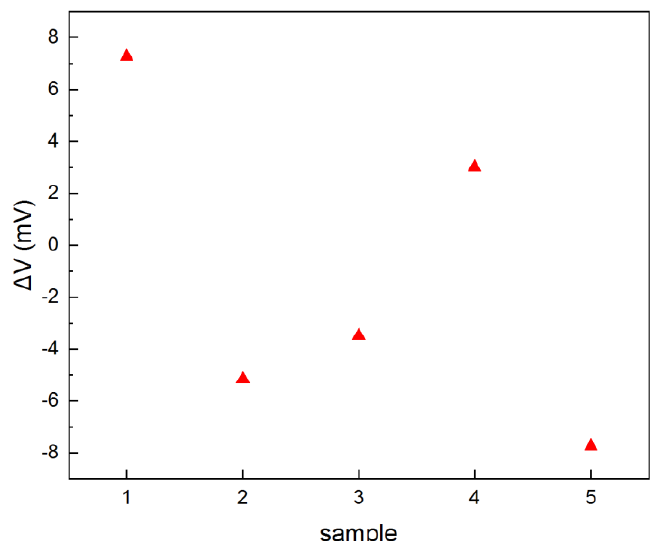
Figure 18. Output voltage difference of the Wheatstone bridge before and after the flip-chip bonding process.